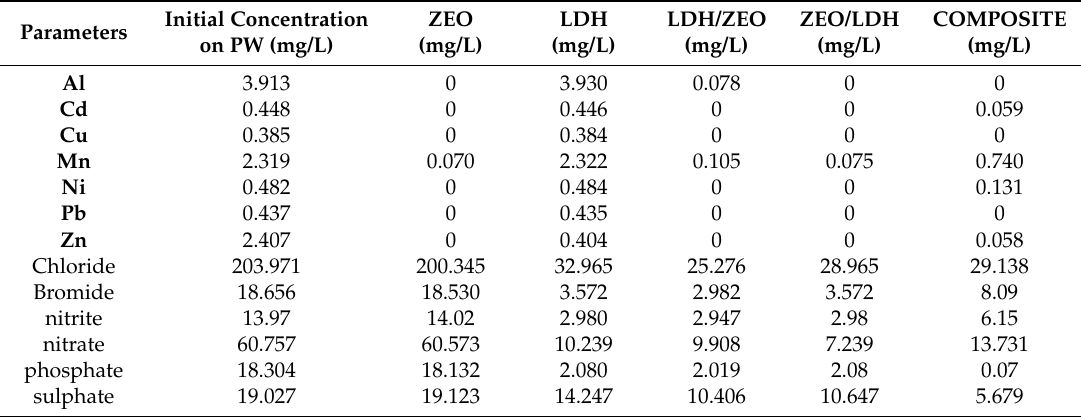
Table 3. Adsorption results for the synthesized